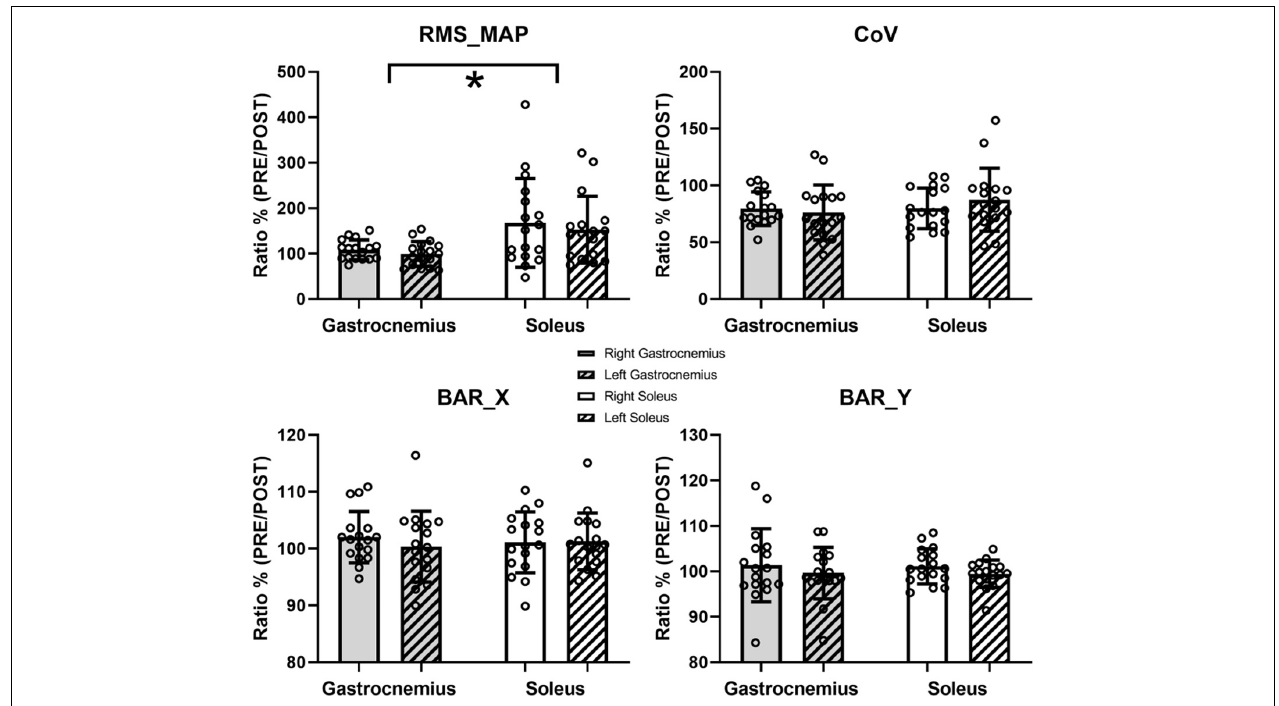
FIGURE 3 | Results of the EMG analysis. Data are presented as means and standard deviations. RMS_MAP, CoV, and barycenter coordinate (BAR_X and BAR_Y) are reported. * represents statistically significant differences between muscles ( p < 0.05).